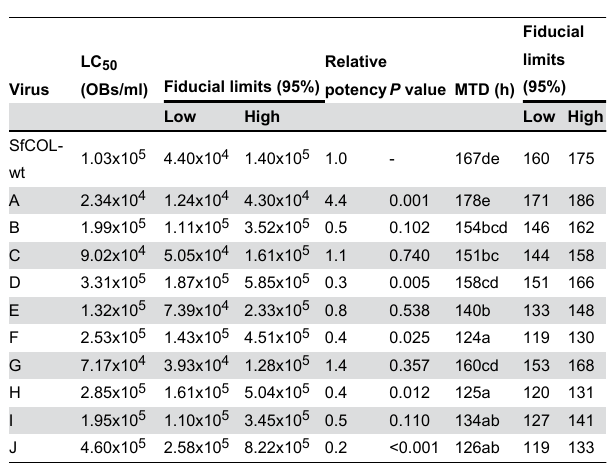
Table 1. Estimated 50% lethal concentration (LC potency and mean time to death (MTD) values of SfCOL genotypic variant OBs in Spodoptera frugiperda second